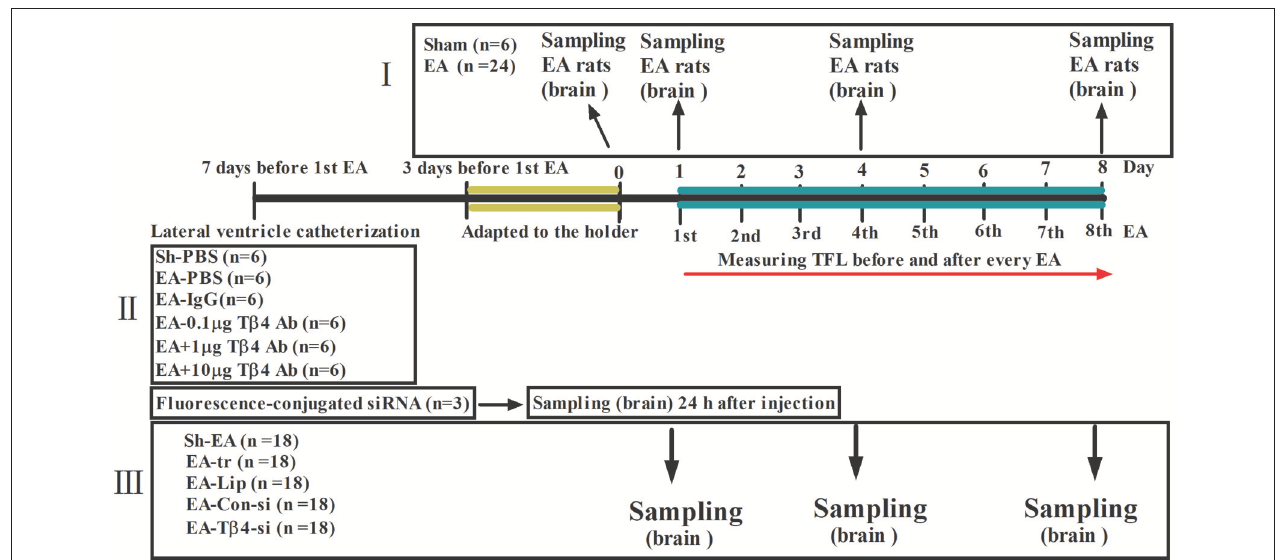
FIGURE 1 | The scheme of experiment. (I) The rats in EA group were treated with EA (2/15Hz, 30min) once per day for 8 days consecutively. The rats in sham group were treated in the same manner as the rats in EA group, but without electricity. (II) The rats in EA-0.1 µ g Ab, EA-1 µ g Ab, EA-10 µ g Ab, or EA-IgG group were intracerebroventricularly injected with 15 µ L 0.1 µ g, 1 µ g, 10 µ g T β 4 neutralizing antibody or isotype IgG, respectively. The rats in Sh-PBS and EA-PBS groups were treated with 15 µ L PBS. The rats except those in Sh-PBS group were treated with EA (2/15Hz, 30min) 30min after intracerebroventricular (icv) injection, for total 8 times. The rats in Sh-PBS group were treated as the same as the rats in EA-PBS group, but without electricity. (III) The rats in EA-L, EA-C-si, or EA-T β 4-si group were intracerebroventricularly injected with lipofection, lipofection mixture with control siRNA or T β 4 siRNA, respectively. The rats except those in Sh-EA group were treated with EA (2/15Hz, 30min) at the day after icv injection and thereafter every day, for total 8 times. The rats in Sh-EA group were treated as the same as the rats in EA-tr group, but without electricity. The tail flick latency (TFL) was examined every day immediately before and after EA, respectively. The symbols have the same meanings in Figures 2 – 5